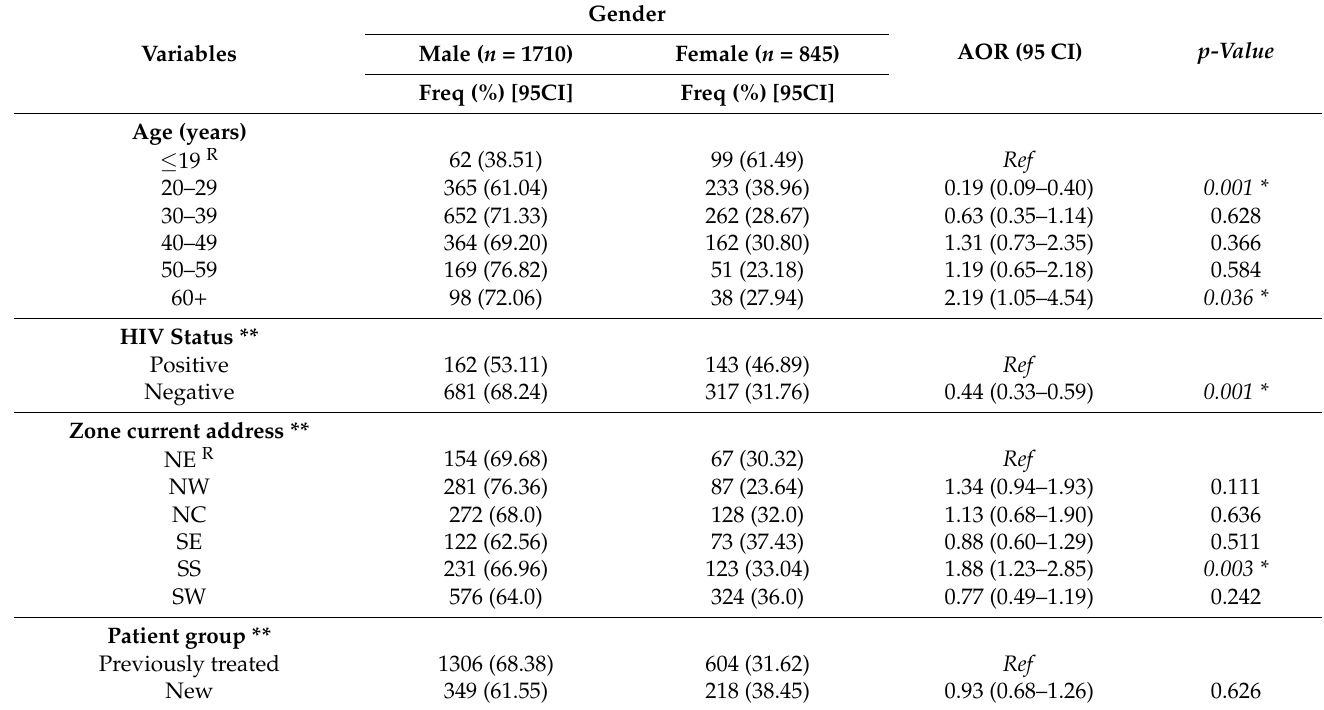
Table 3. Association of gender and DR-TB cases in Nigeria (2010–2016) ( n = 2555 )